Question: Compose a caption that would accompany this figure in a paper.
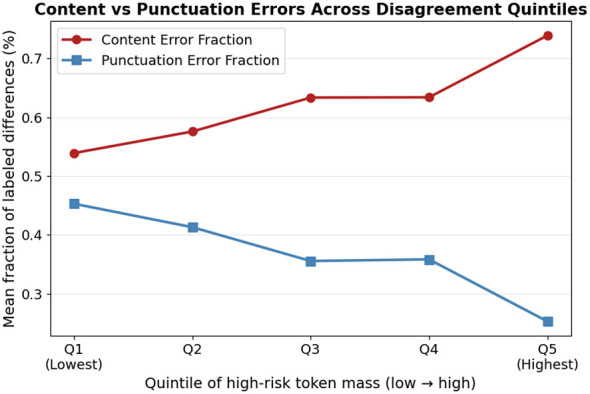
Answer: Disagreement composition across quintiles of high-risk token mass (Consensus mode; high-risk defined as A i ≤ 3). Points show quintile means of the fraction of labeled differences attributed to Content and Punctuation categories. Quintiles are defined by high-risk token mass (percentage of evaluated aligned positions with A i ≤ 3).